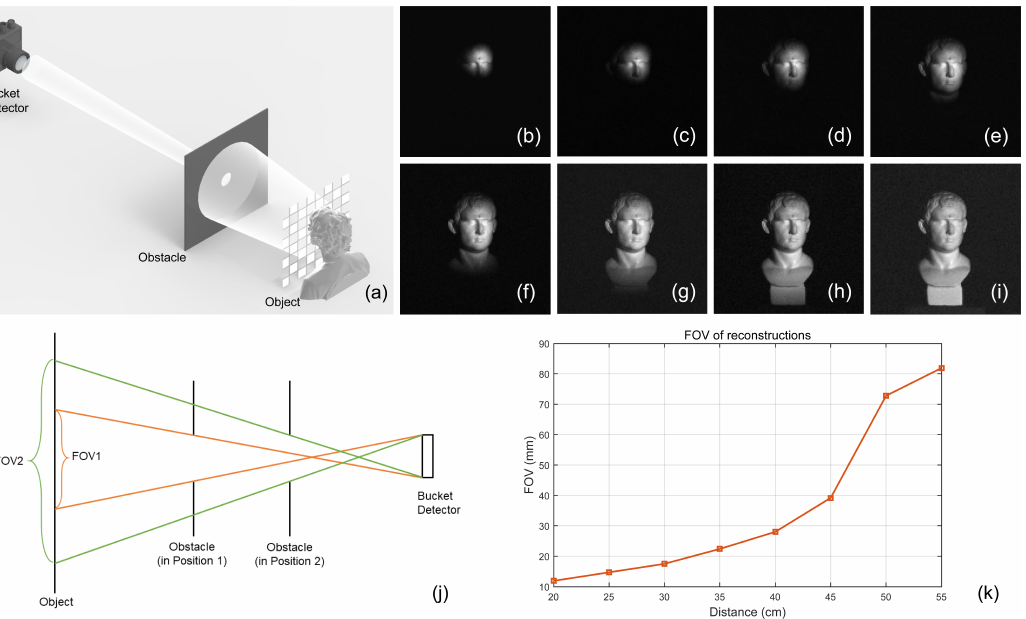
Figure 3. ( a ) Schematic diagram of detection part in FOV restricted detection. The distance between object and bucket detector is 60 cm. A 3D-printed circular iris in a diameter of 1 cm is used as an obstacle and placed in detection part to restrict FOV. ( b – i ) The reconstructions of gradually moving the obstacle away from the object to the detector, and the distance of every movement is 5 cm. ( b ) is the reconstructed image when the obstacle is 20 cm away from the object. ( i ) is the result with the distance between object and obstacle is 55 cm, which indicate that when obstacle clings to bucket detector. ( j ) Illustration of restricted FOV caused by obstacle in detection part. Orange solid line and Green solid line indicates the FOV determined by the detector and the obstacle in position 1 and position 2, respectively. ( k ) The linear FOV of reconstructions with respect to the distance between the obstacle and the